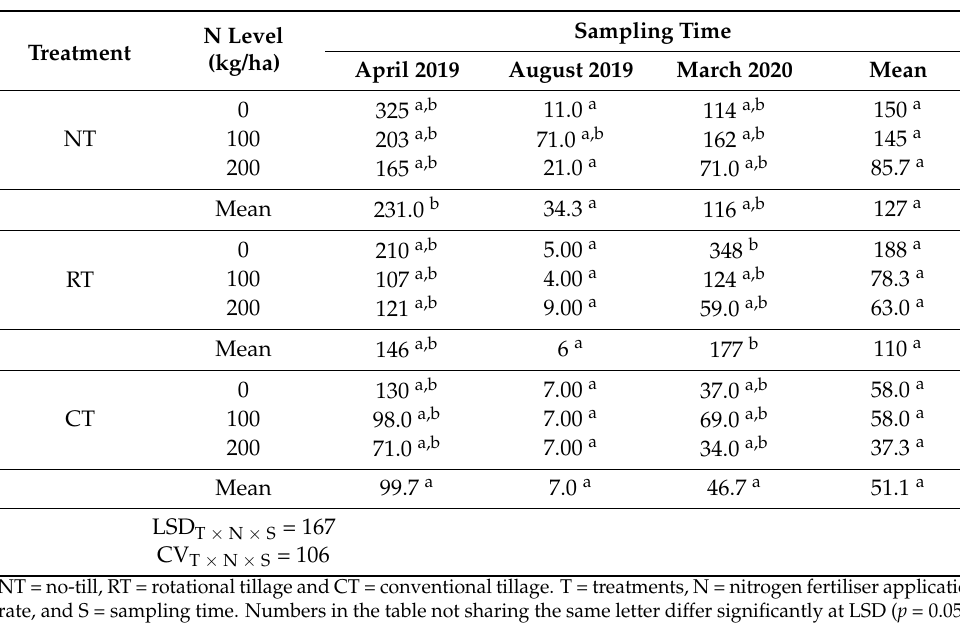
Table 4. Abundance of soil macrofauna under different tillage treatments (NT = no-till, RT = rotational tillage and CT = conventional tillage), sampling times (April 2019, August 2019 and March 2020) and nitrogen fertiliser application rates (0, 100 and 200 kg/ha).